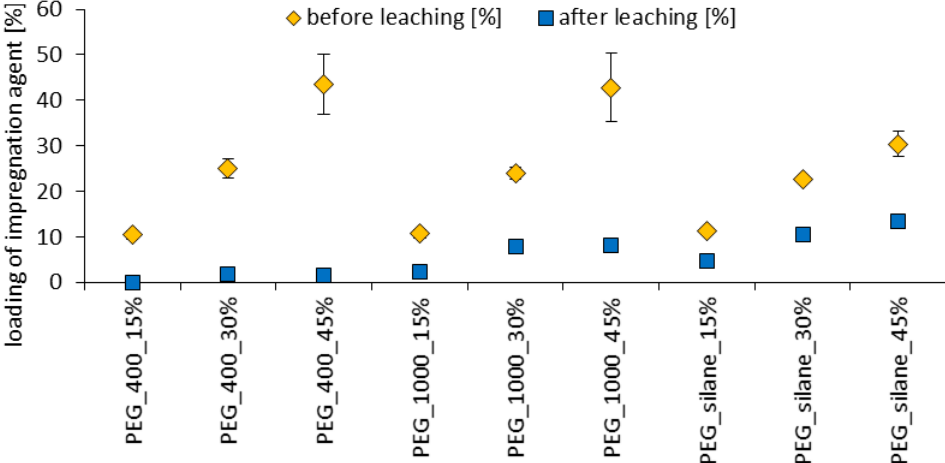
Figure 4. Impregnation agent loading before and after EN 84 [33] leaching test. Standard deviation given in whiskers. There is a significant loss for all samples.